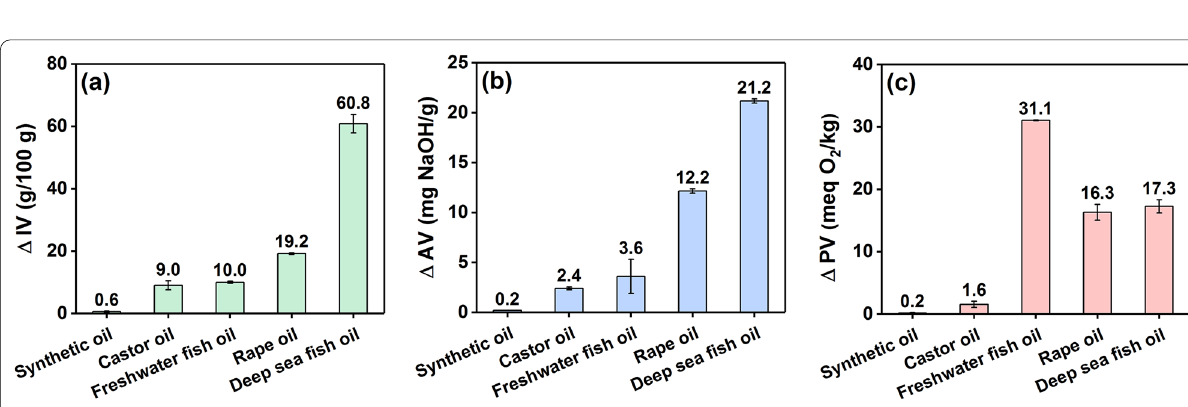
Fig. 4 Changes in iodine value ( a ), acid value ( b ), and peroxide value ( c ) of synthetic and natural oils after accelerated oxidation (100 °C, 10 L/h air, 12